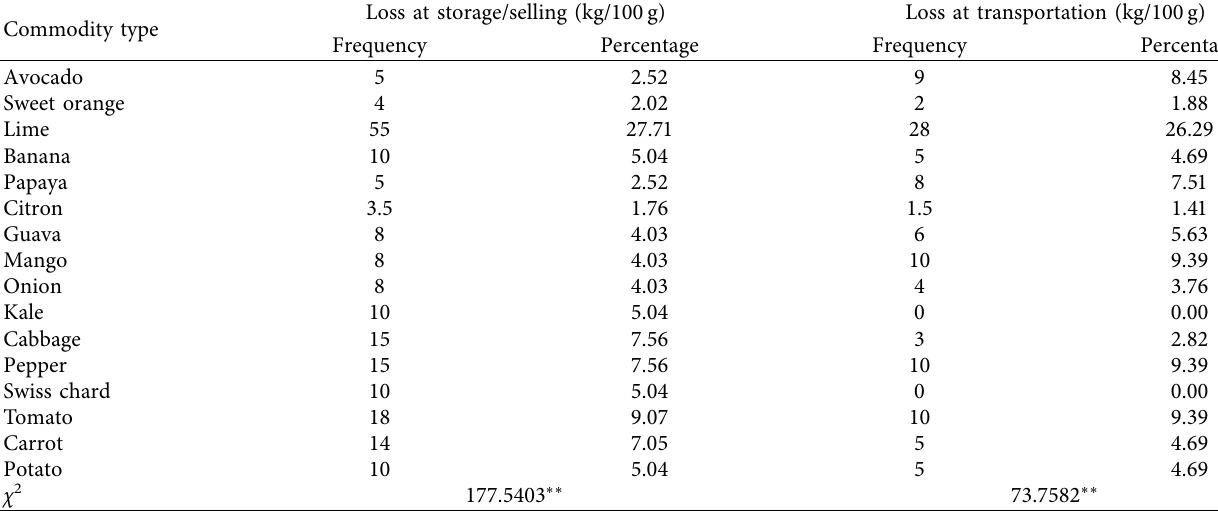
Table 6: Fruits and vegetables postharvest losses extent.